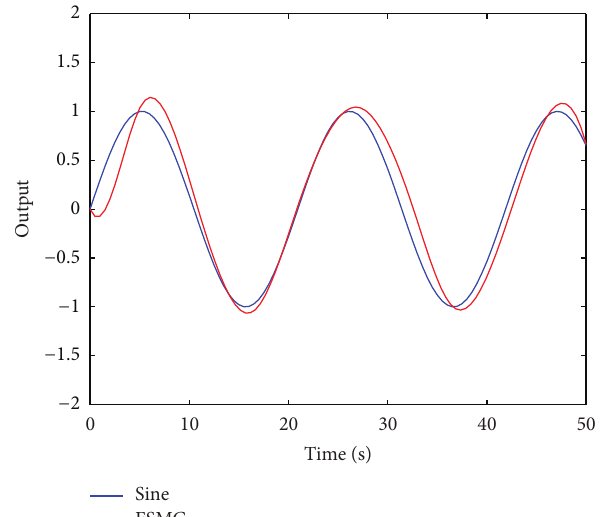
Figure 4: Sine wave response.